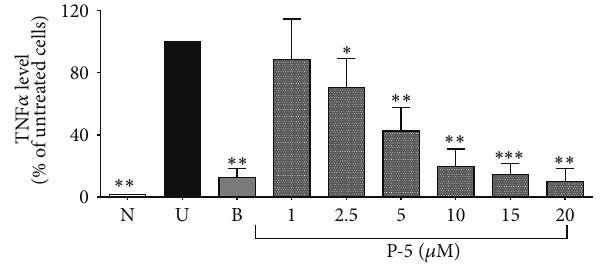
Figure 2: The reduction of TNF 𝛼 levels (expressed as the fraction, in %, of TNF 𝛼 level secreted by untreated cells) caused by a low concentration range (1–20 𝜇 M) of P-5 as measured in LPS-activated macrophages. N: naive control; U: untreated control; B: budesonide (10 𝜇 M, positive control). Shown is the mean of three different experiments ± S.D. ANOVA of the effect of P-5 on reduction of TNF 𝛼 was F 8,97 = 119.21, 𝑝 < 0.00001 . ∗ 𝑝 < 0.05 ; ∗∗ 𝑝 < 0.01 ; ∗∗∗ 𝑝 < 0.001 , compared to untreated macrophages.